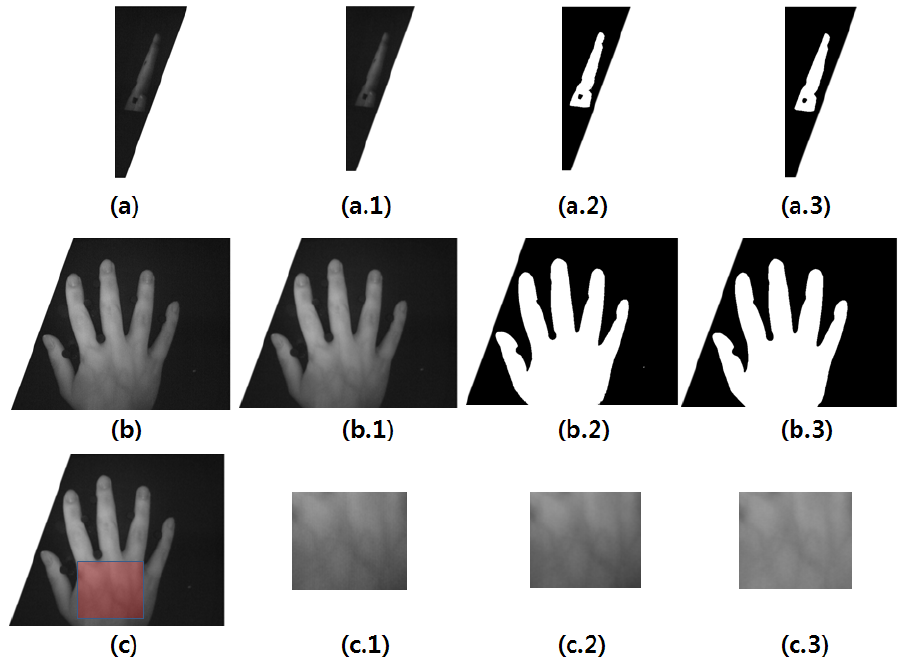
Figure 3. Preprocessing for hand recognition. ( a ) the side view of the hand, ( a.1 ) Gaussian filter, ( a.2 ) threshold, ( a.3 ) median filter; ( b ) the back-of-the-hand view, ( b.1 ) Gaussian filter, ( b.2 ) threshold, ( b.3 ) median filter; ( c ) the region of interest (ROI) of vascular, ( c.1 ) vascular image, ( c.2 ) Gaussian filter, and ( c.3 ) high-pass filter.